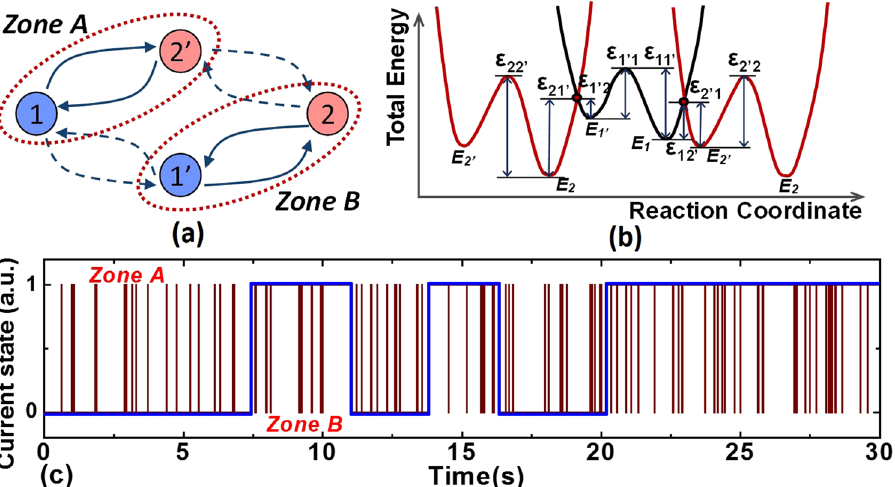
Figure 6. ( a ) Illustration of the complete 4-state model. The zone A and zone B in rRTN correspond to the transition processes in circles. ( b ) Schematic of the corresponding reaction coordinate of the complete 4-state trap model. ( c ) Theoretical simulated RTN results based on the extracted time constants associated with the complete 4-state trap model, which are consistent with the experimental results in Fig.